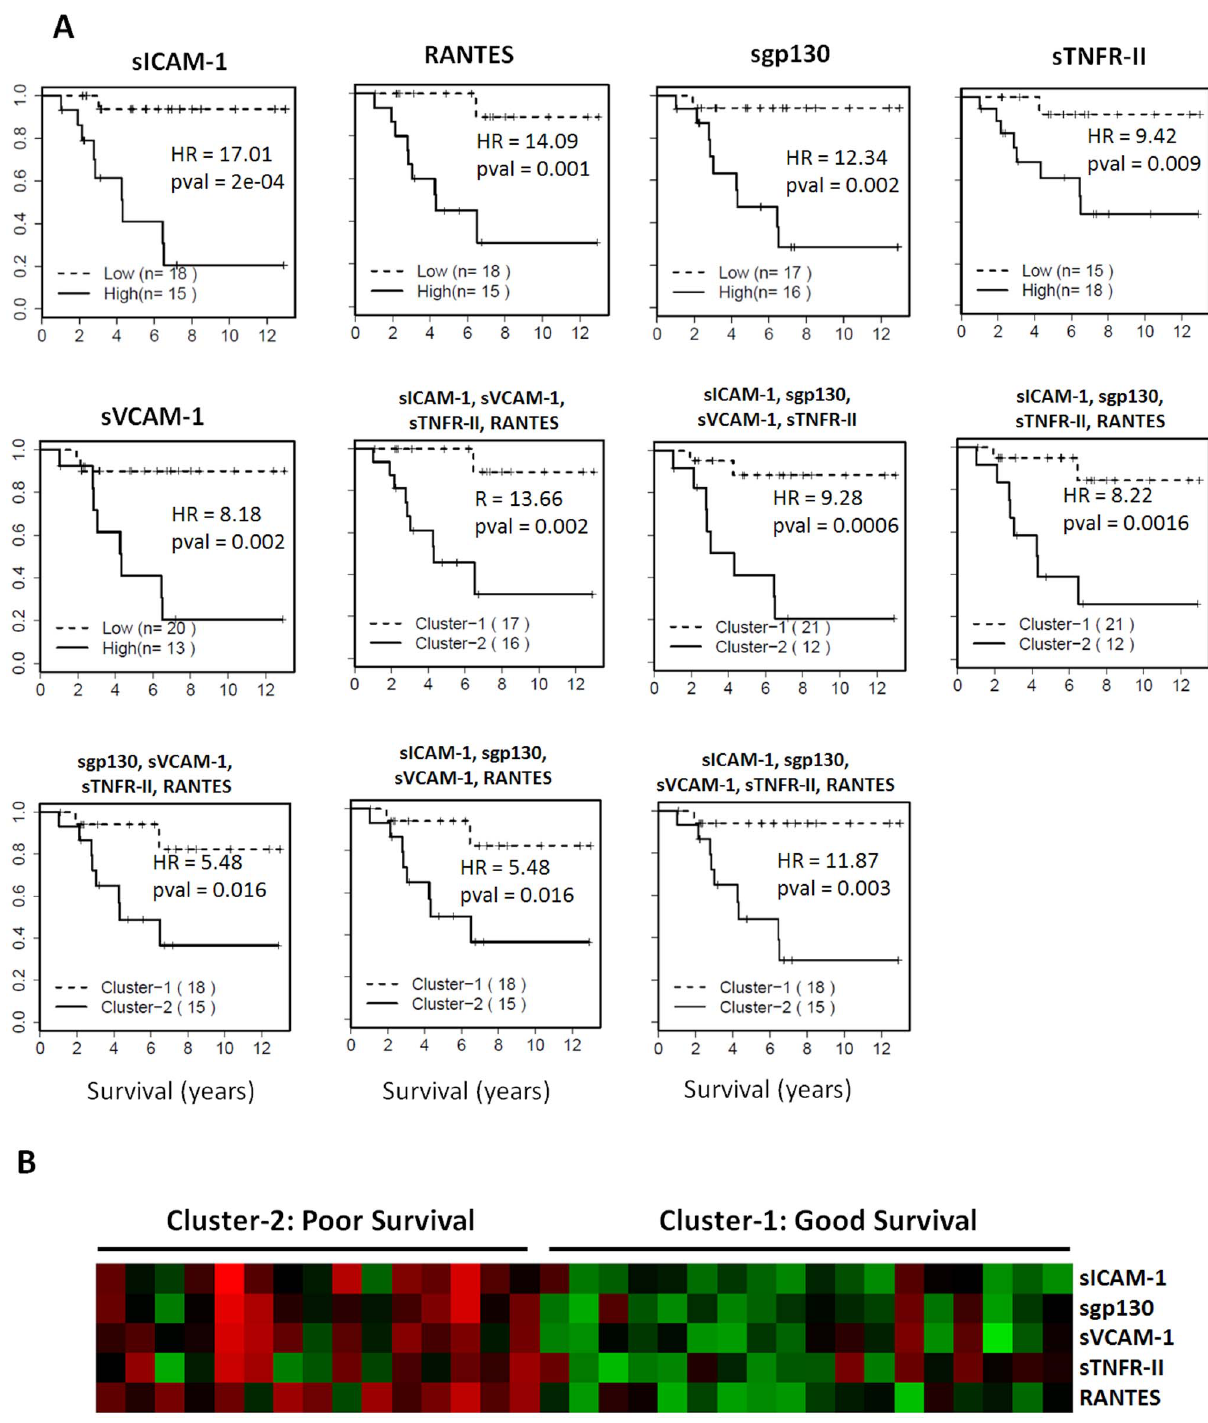
Figure 5. Survival analyses of the samples from the RM stage. A: The survival curves for the top five molecules that can distinguish patient subset with poor overall survival from patients with better survival. The prognostic value of multivariate models (combinations of 4 or 5 proteins) was determined by clustering the patients into two groups based on the expression levels of protein panels and survival differences were then determined between these two clusters using Kaplan-Meier analyses. B: The heatmap of protein expression in the samples from the RM stage. The patients with poor survival have higher expression levels for the five proteins.